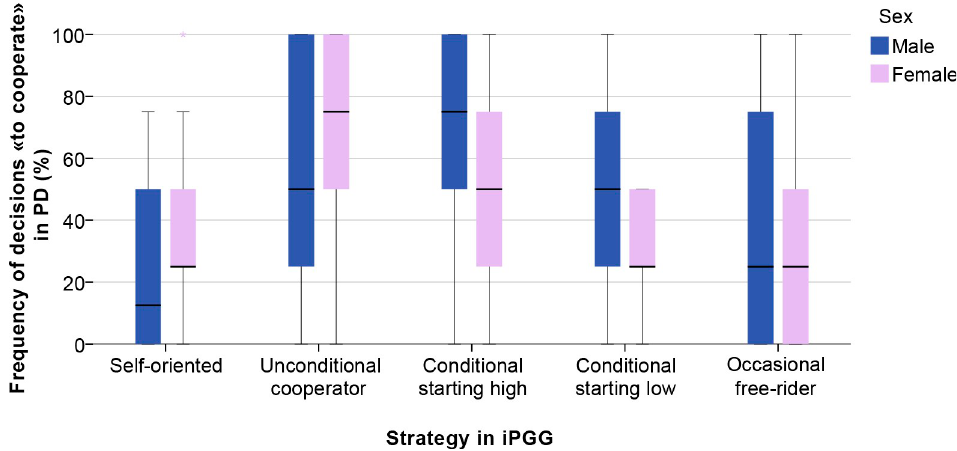
Fig 5. Correspondence of individual strategies in iterated Public Goods Game and cooperativeness in Prisoner’s Dilemma games for men and women. The dark line in the middle of the boxes is the median. The bottom of the box indicates the 25th percentile, the top of the box indicates the 75th percentile. The T-bars (whiskers) extend to 1.5 times the height of the box or, if no case has a value in that range, to the minimum or maximum values.